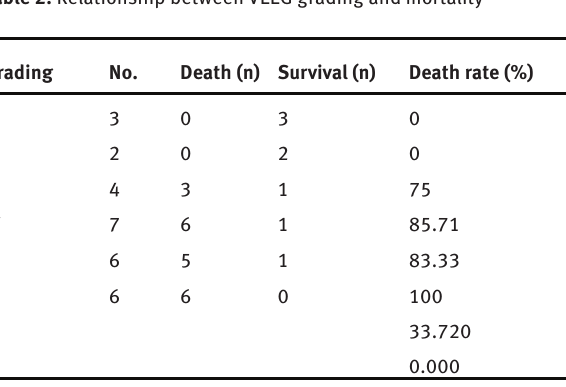
Table 2: Relationship between VEEG grading and mortality